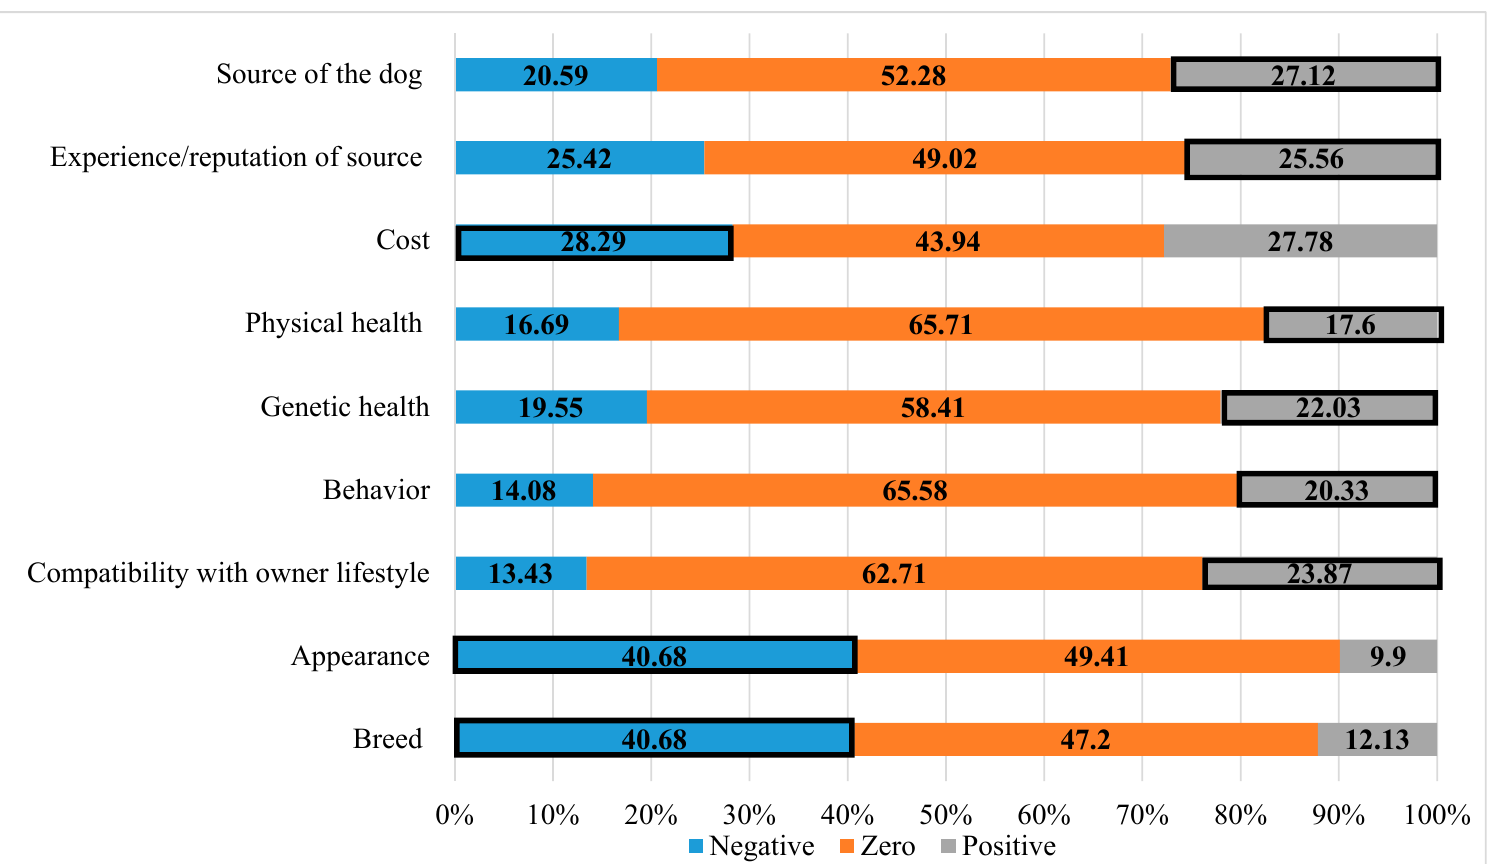
Figure 3. Distribution of social desirability bias for dog characteristic preferences. Social desirability bias was calculated as the difference in the score on the Likert-scale the respondent indicated for the level of importance and the score they indicated for what they thought others placed on each dog characteristic. Depending on the question, social desirability bias is indicated with having a lower score or a higher score than what others believed. Evidence of social desirability bias indicated by boxes (n = 767).